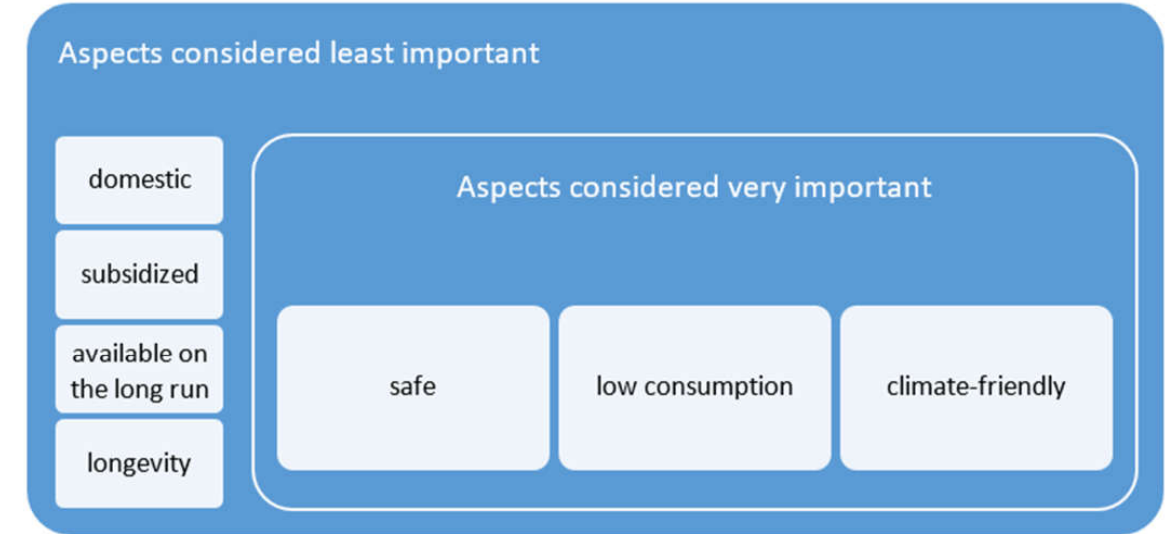
Figure 4. Some aspects of minor and major importance in connection with heating energy generation modes. Compiled by the authors.